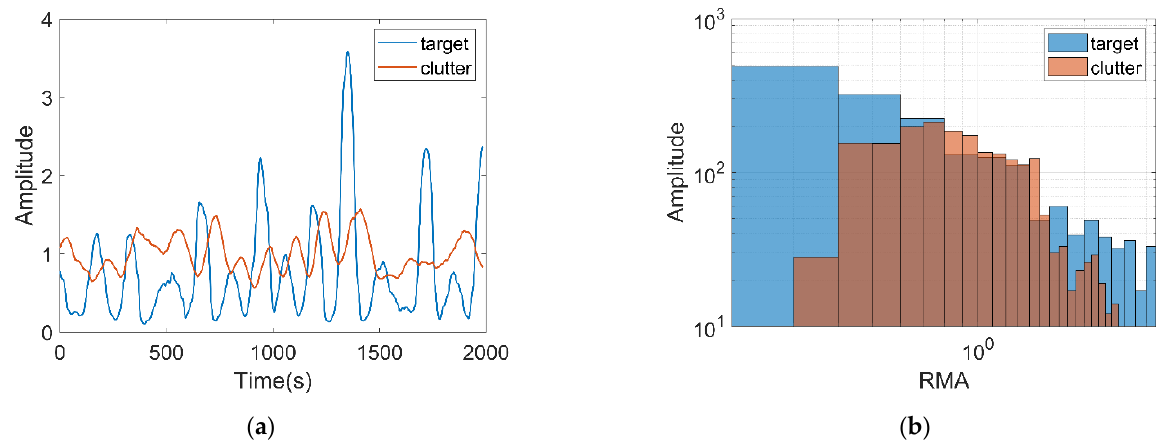
Figure 3. Relative mean amplitude (RMA) feature of the first dataset. ( a ) The amplitude of primary cell where target exists and the average amplitude of clutter-only cell; ( b ) The histogram of RMA at the primary cell where target exists and randomly selected clutter-only cell.